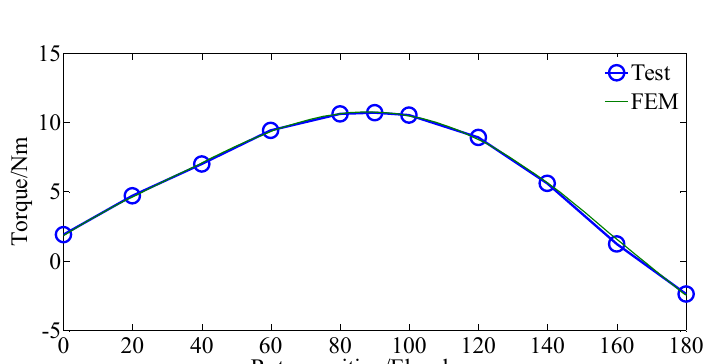
Figure 13. Back EMF waveforms.